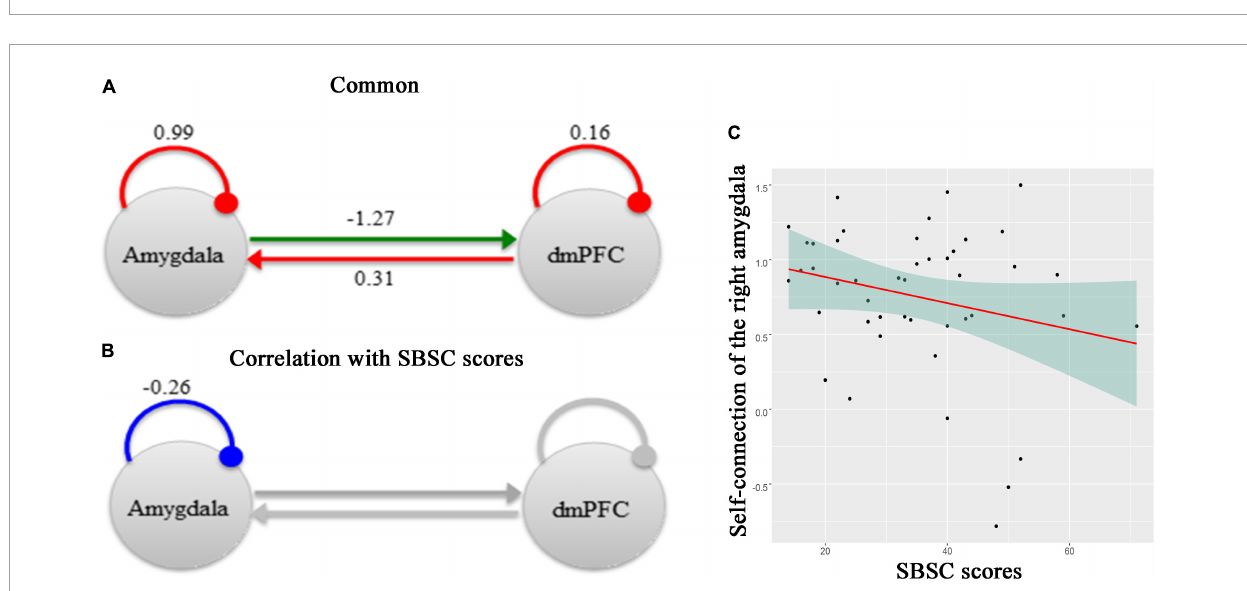
FIGURE3 A schematic summarizing effective connectivity between the right amygdala and the dmPFC across participants in the Hubei Cohort and its correlation with stress responses at the first survey. (A) The green arrow represents the positive extrinsic effective connectivity and the red arrow represents the negative extrinsic effective connectivity. The parameters are the strength of connectivity. The red arcs represent self-connections. For the self-connections, the parameters are log scaling parameters, which can be converted to units of Hz by: y =–0.5 ∗ exp(x). Where x is the log scaling parameter, − 0.5 Hz is the prior and y is the self-connection strength in units of Hz. (B) The parameter is the effect of the stress responses on the self-connection. All of the other connections in this network, which had no correlations with the SBSC scores, were shown in gray. (C) A scatter plot showing the relationship between the self-connection in the right amygdala and the stress